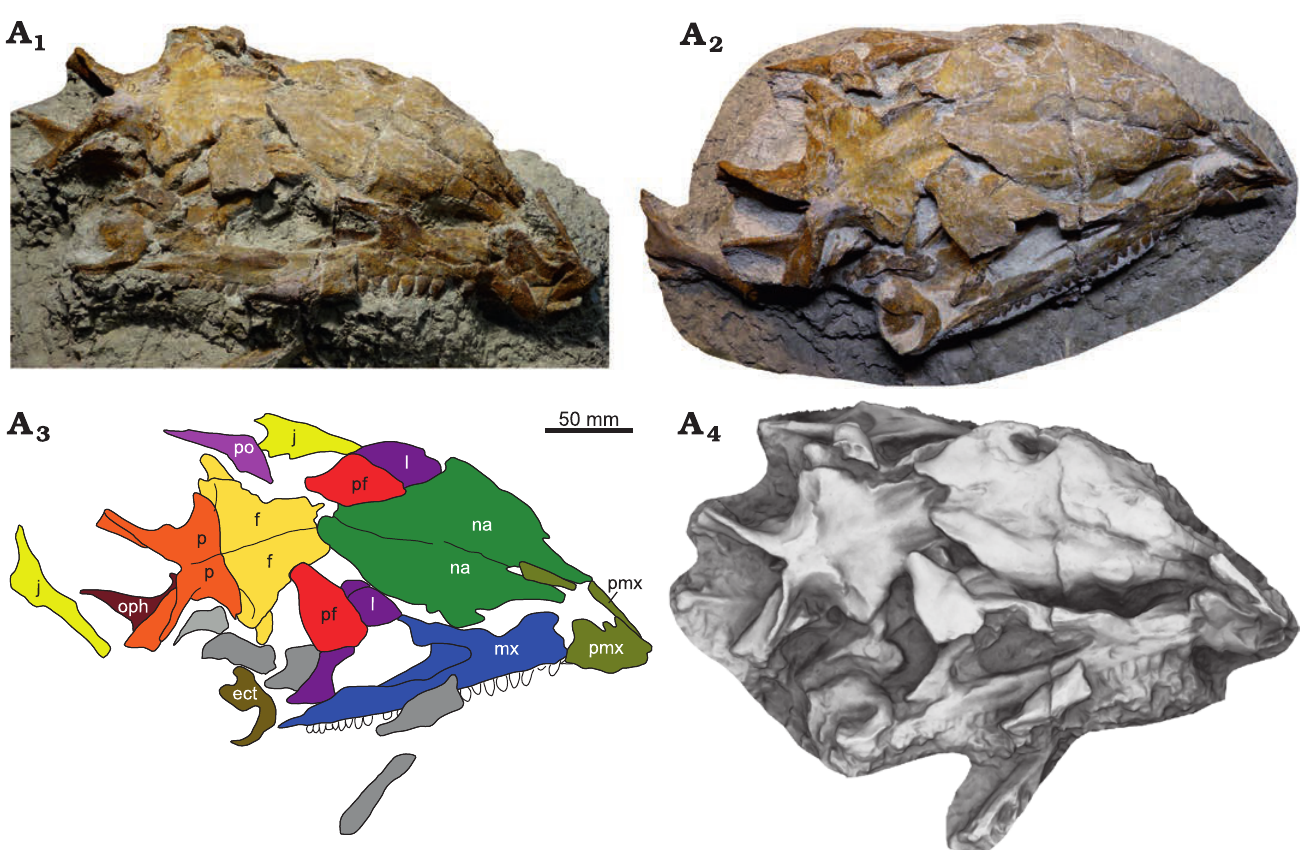
Fig. 11. Skull of Plateosaurus trossingensis (MSF 17.4) from the Triassic of Frick, Switzerland. Photograph of the skull in dorsolateral view at an early stage of preparation (A 1 ); photograph of the skull in oblique dorsolateral view at the final stage of preparation (A 2 ), note the additionally exposed jugal; interpretational diagram (A 3 ); ambient occlusion of photogrammetric model of the preparation state shown in A 1 (A 4 ). Abbreviations: ect, ectopterygoid; f, frontal; j, jugal; l, lacrimal; mx, maxilla; na, nasal; oph, opisthotic; p, parietal; pf, prefrontal; pmx, premaxilla; po, postorbital; ud,